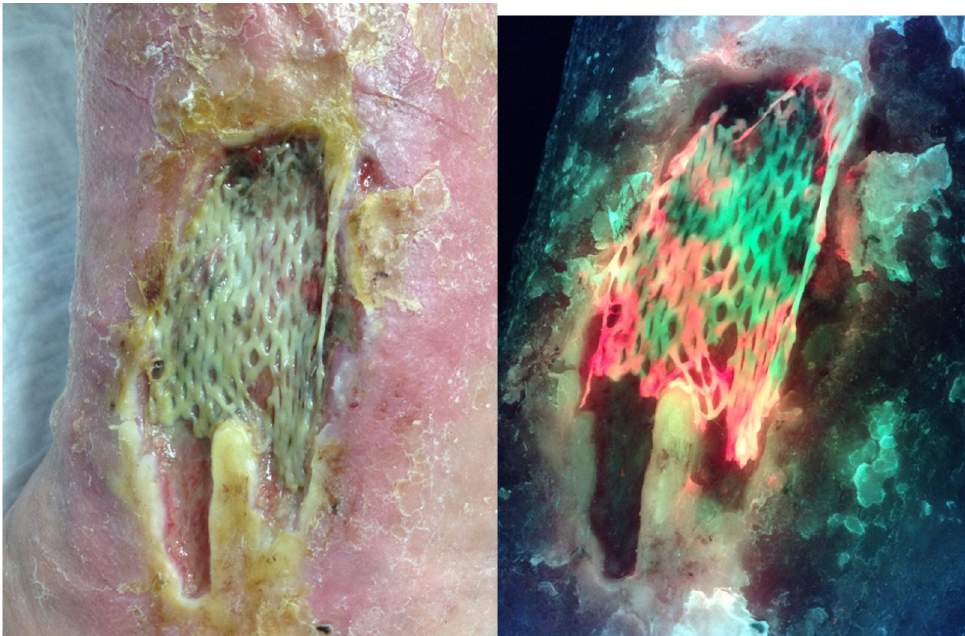
Figure 3. Standard and fluorescence images one week following application of a Cellular- and/or Tissue-Based Product (CTP) on a medical gaiter venous leg ulcer showing red fluorescence associated with the failure.